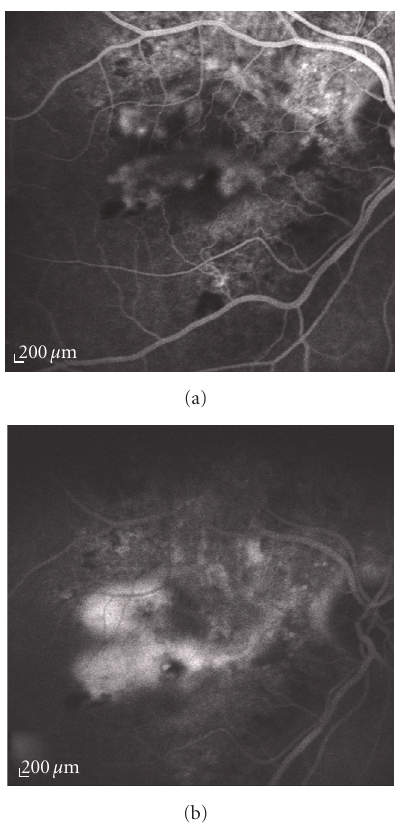
Figure 1: Fluorescein angiography of a classic choroidal neo- vascularization. (a) Early and (b) late angiograms: the lesion is characterized by a well demarcated area of early fluorescence with a progressive leakage of the dye to the subretinal space leading to blurring of the borders in the late phase of the exam.